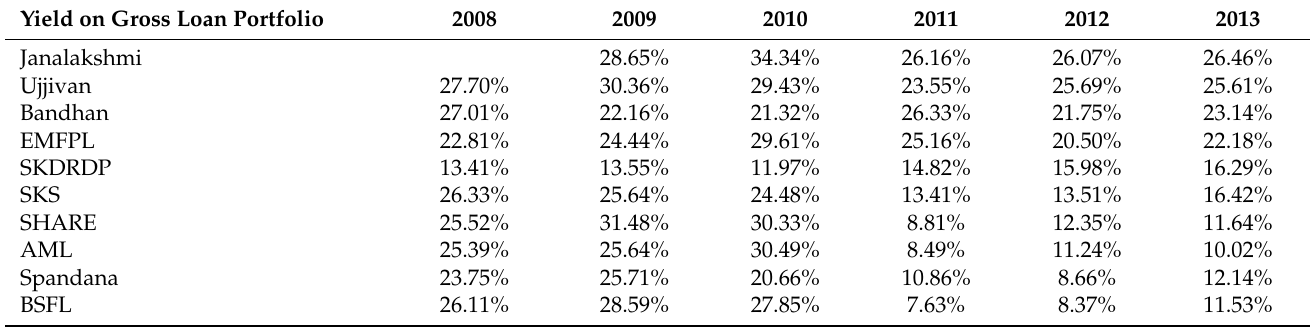
Table A2. Yield of Top Indian MFIs.